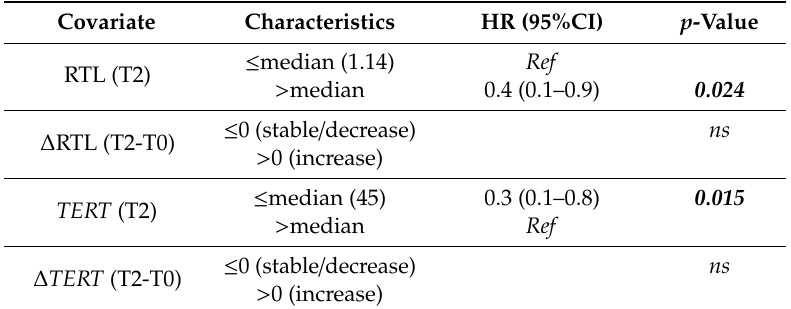
Figure 5. Kaplan-Meier curves for event-free-survival according to ( a ) relative telomere length (RTL) above or below the median at T2, ( b ) ∆ RTL (T2-T0) stable / decrease or increase zero, ( c ) TERT levels above or below the median at T2 and ( d ) ∆ TERT mRNA (T2-T0) stable / decrease or increase. Table 3. Multivariable Cox regression analysis indicating associations between covariates of interest and event free survival.